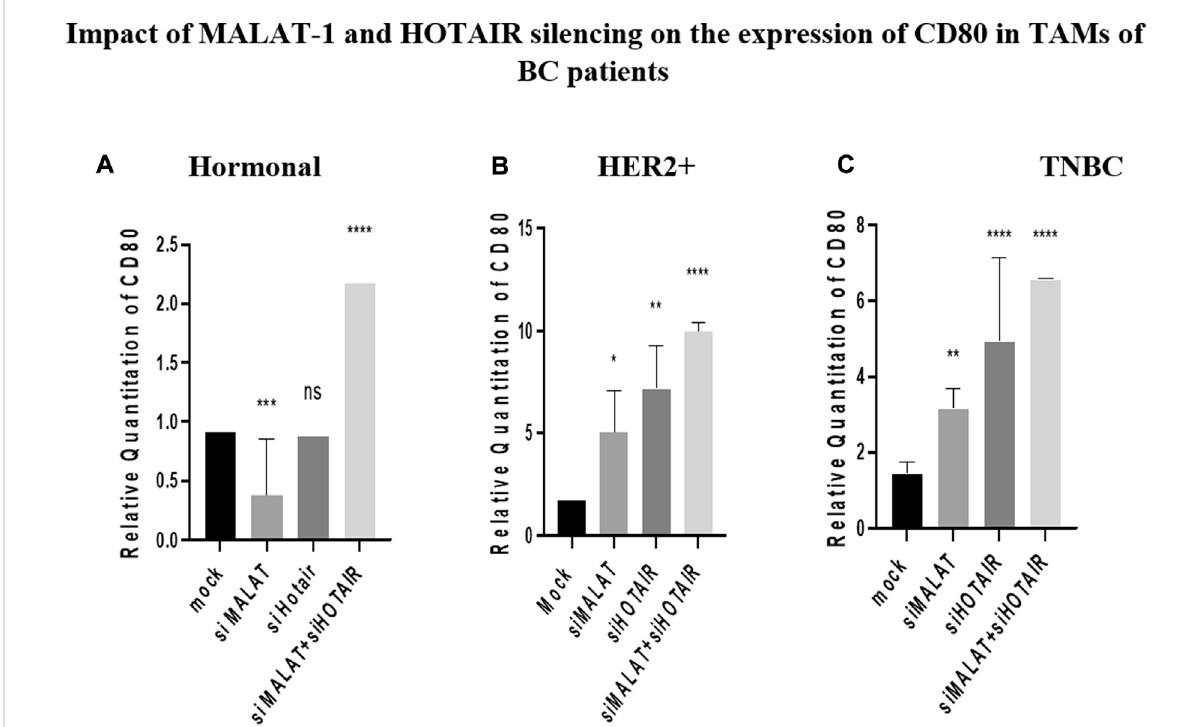
FIGURE 6 Impact of MALAT1 and HOTAIR silencing on the expression of CD80 in TAMs of (A) hormonal, (B) HER2+, and (C) TNBC. CD80 mRNA levels weremeasuredusingqRT-PCRandwerenormalizedto β -actin(endogenouscontrol).TheresultsshowthatMALAT1silencingresultedinstatistically signi fi cant upregulation in CD80 in HER2+ and TNBC subtypes; however, more signi fi cant upregulation of CD80 was observed on transfection with silencer against HOTAIR in comparison to untransfected controls (mocks). Conversely, CD80 expression was downregulated upon silencing MALAT1 in TAMs of the hormonal subtype while showing non-signi fi cant expression upon silencing of HOTAIR in comparison to untransfected controls(mocks).Meanwhile,co-transfectionofHOTAIRsilencerswithMALAT1silencersresultedinadramaticupregulationinthethreesubtypesin comparison to untransfected controls (mocks). One-way Anova followed by Dunette ’ s test of multiple comparison was used for the purpose of comparison between more than two different studied groups. **** = p < 0.0001, *** = p < 0.001, ** = p < 0.01, * = p < 0.05, and ns = statistically not signi fi